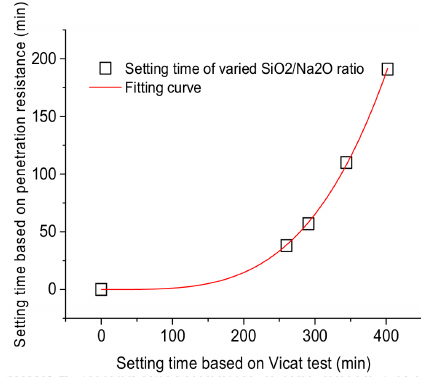
Figure 7. Relationship between the measured results of setting